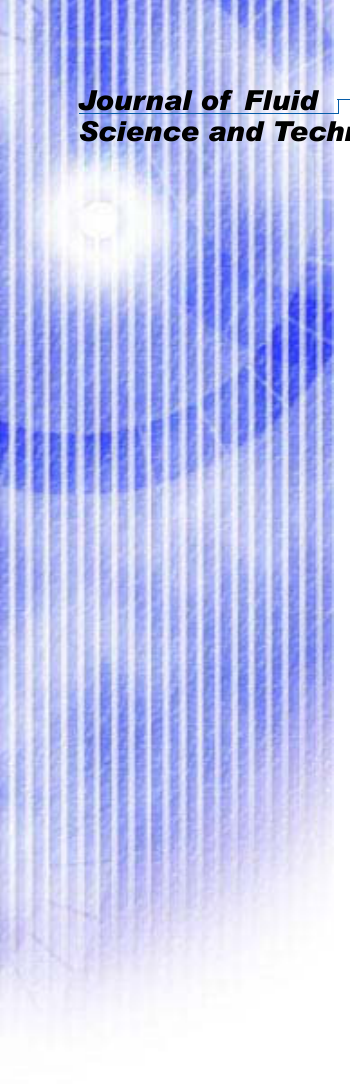
Table 1 Comparison with other experimental results